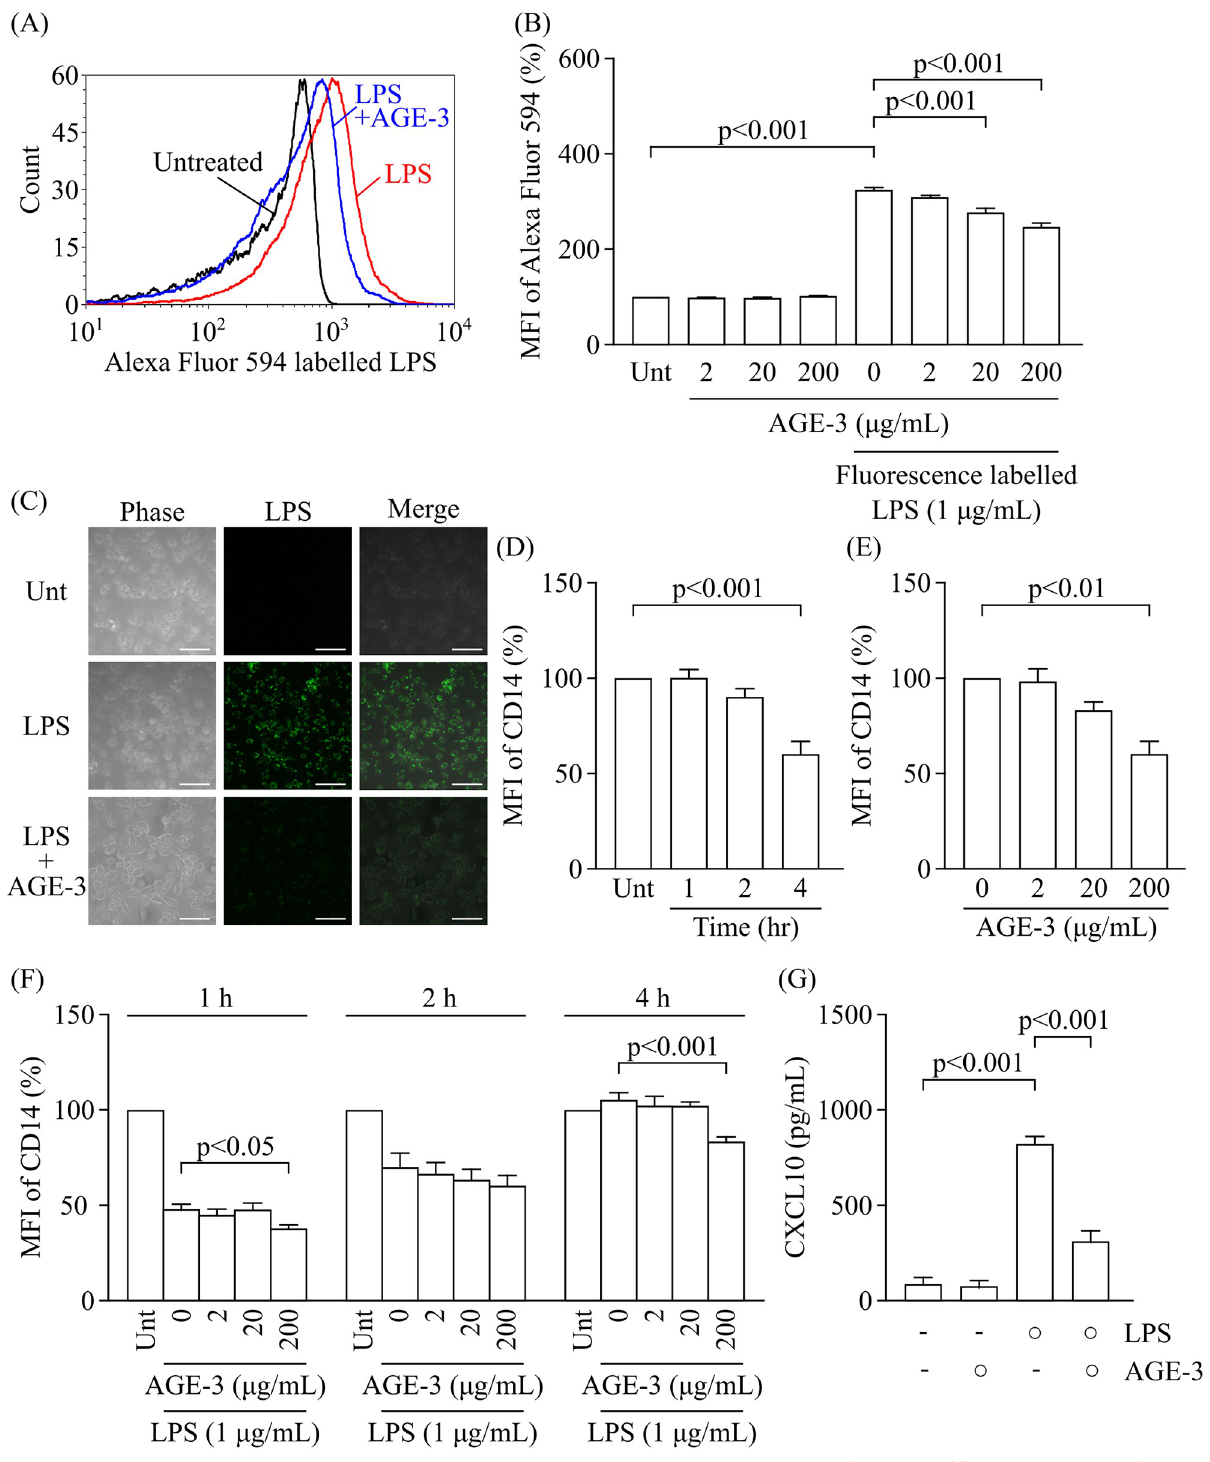
Fig 3. Inhibitory effect of AGE-3 on the cellular response to LPS in RAW264.7 cells. (A) Representative histogram of fluorescence intensity for Alexa Fluor 594-labelled LPS in RAW264.7 cells treated with medium alone (Untreated; greyscale), Alexa Fluor 594-labelled LPS at 1 μ g/mL (red line), and a combination of Alexa Fluor 594-labelled LPS and AGE-3 at 200 μ g/mL (blue line). (B) Effect of AGE-3 on LPS uptake (n = 3, Tukey’s test). Cells were concomitantly treated with Alexa Fluor 594-labelled LPS at 1 μ g/mL and AGE-3 at 200 μ g/mL for 4 h. MFI relative to the untreated group (medium alone) was arbitrarily defined as 100%. (C) Representative images of LPS uptake visualised by Alexa Fluor 488-labelled LPS (green) in